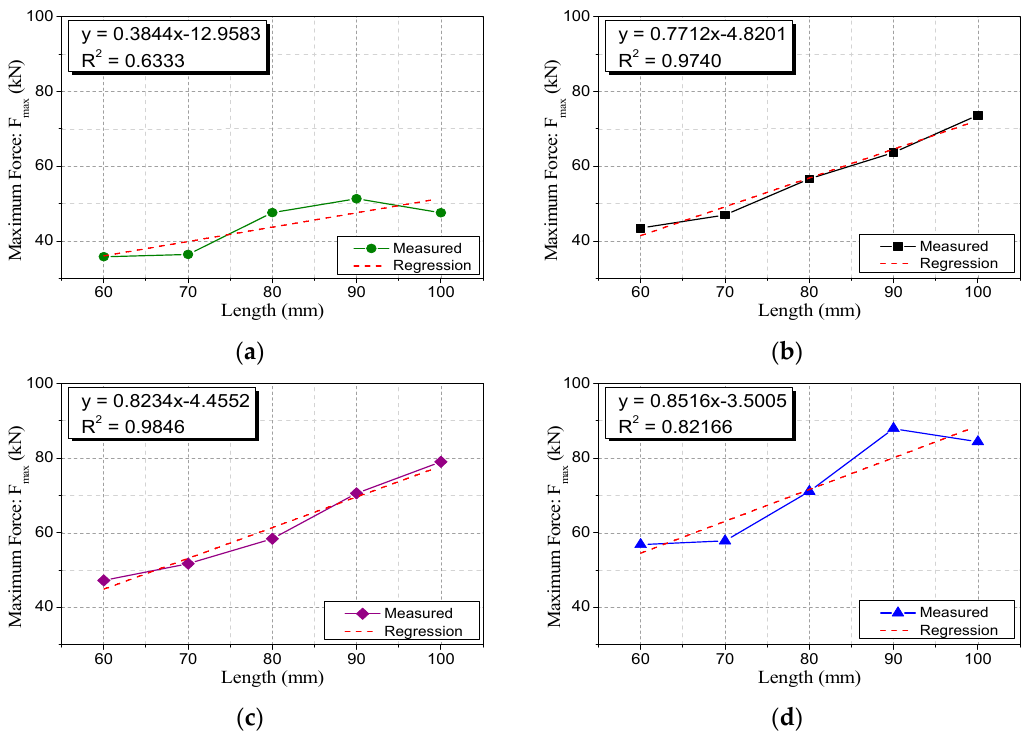
Figure 7. Relationship between length and maximum force. ( a ) Type 1-25%; ( b ) Type 1-30%; ( c ) Type 1-35%; ( d ) Type 1-40%.